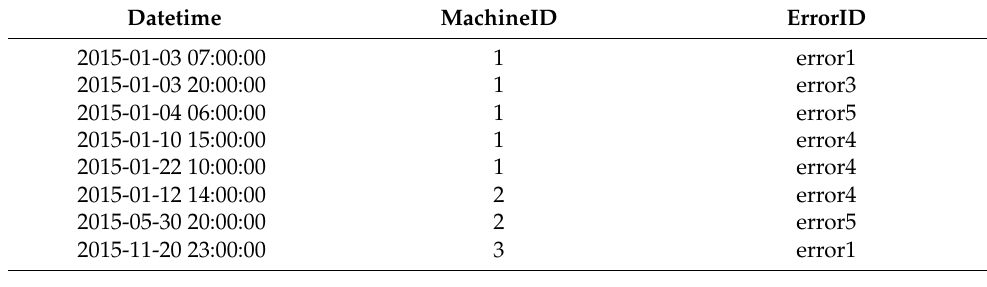
Table 2. Different errorIDs with the respective machineID and